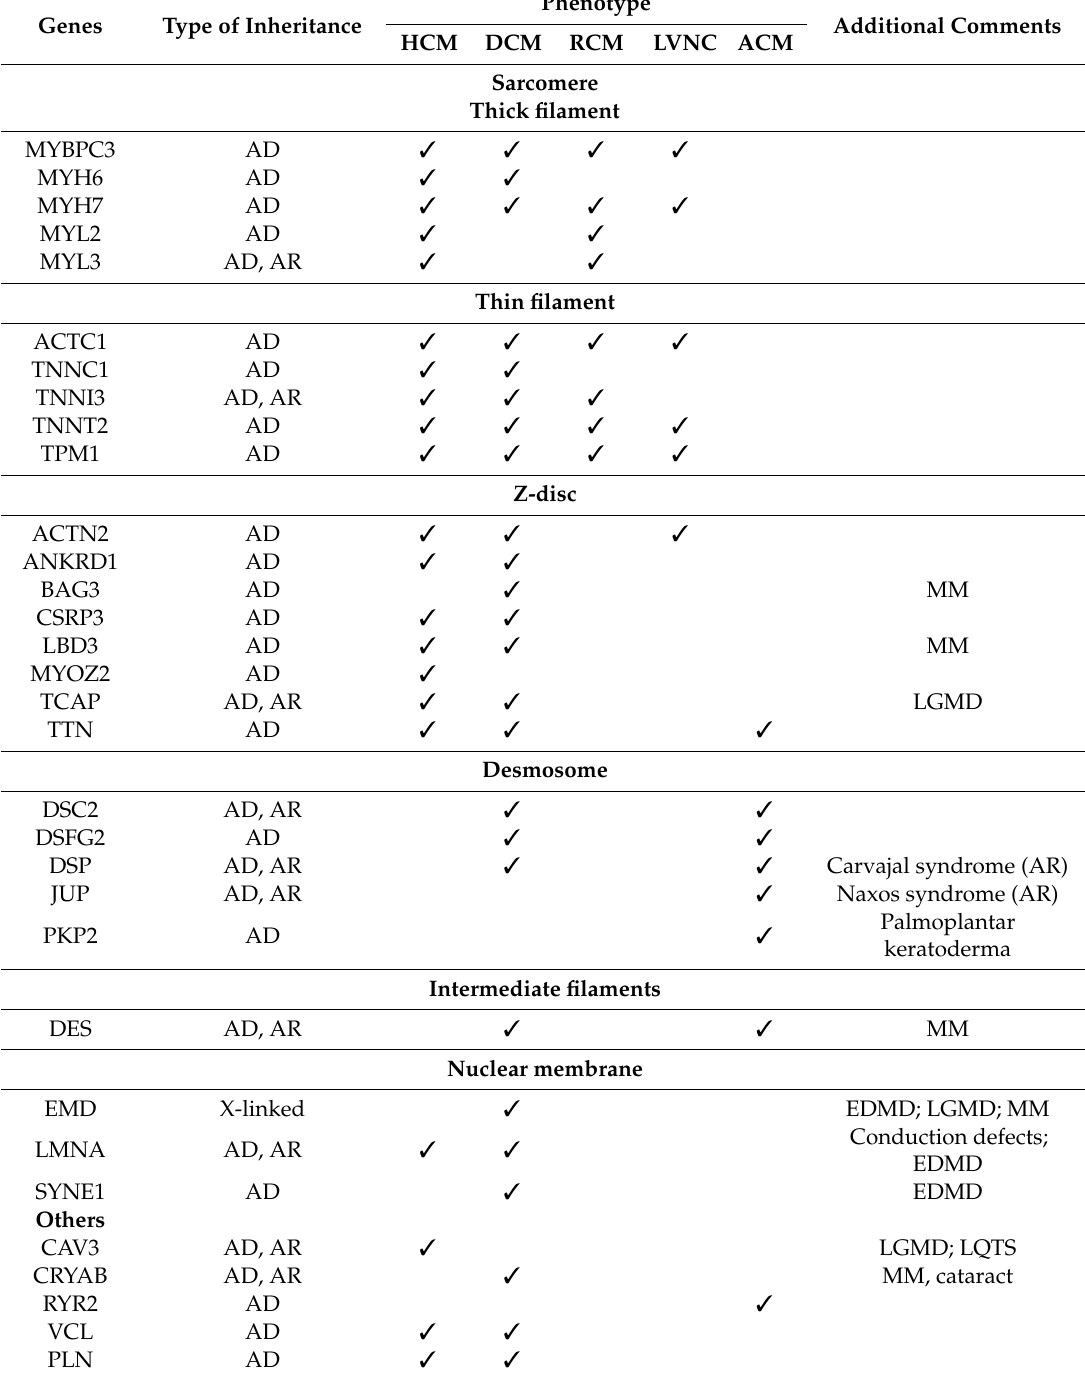
Table 2. Genotype-phenotype correlation in non-syndromic cardiomyopathies. Genes Type of Inheritance